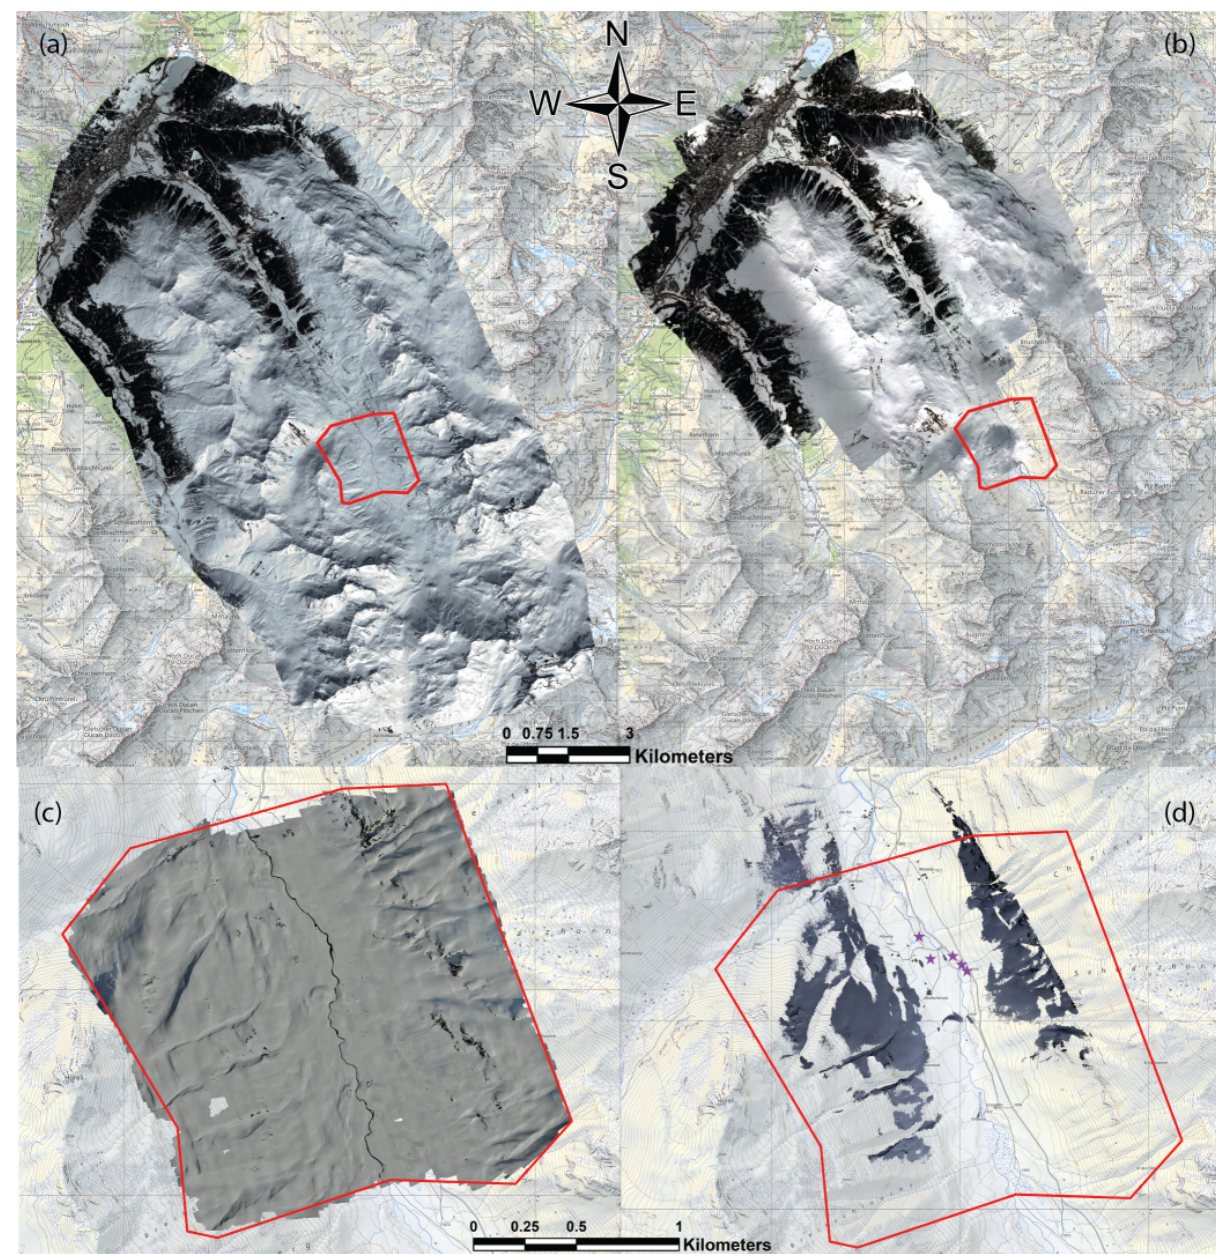
Figure 4. (a) Orthoimage of the satellite data, (b) orthoimage of the airplane data. The area recorded by the airplane is theoretically larger than the area recorded by the satellites, but due to the clouds only part of the images could be used for producing DSM and orthoimagery. (c) The orthoimage of the UAS data and (d) orthoimage of the terrestrial data. The red polygon in (a) , (b) , (c) and (d) indicates the Schürlialp site test. The violet stars in (d) indicate the five camera positions of the terrestrial recordings (Swiss Map Raster, source: Federal Office of Topography; Pléiades data© CNES 2018, Distribution Airbus